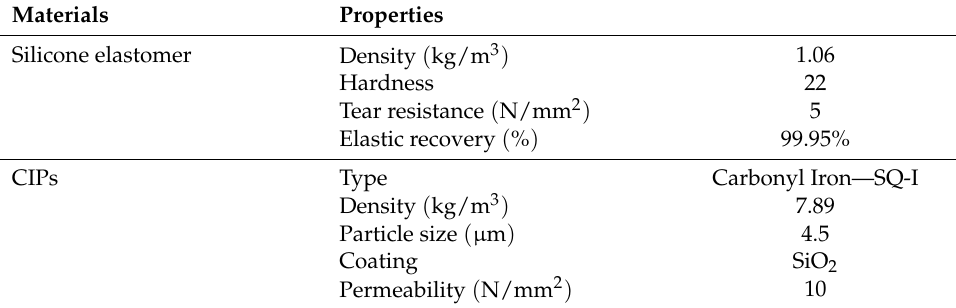
Table 1. Material properties of the silicone elastomer and CIPs.